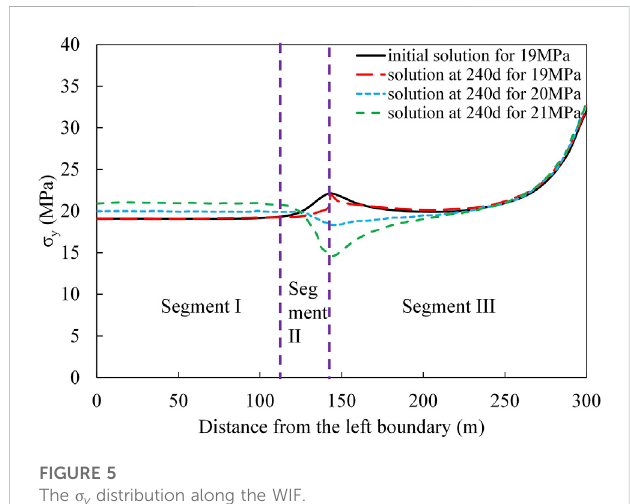
FIGURE 5 The σ y distribution along the WIF.